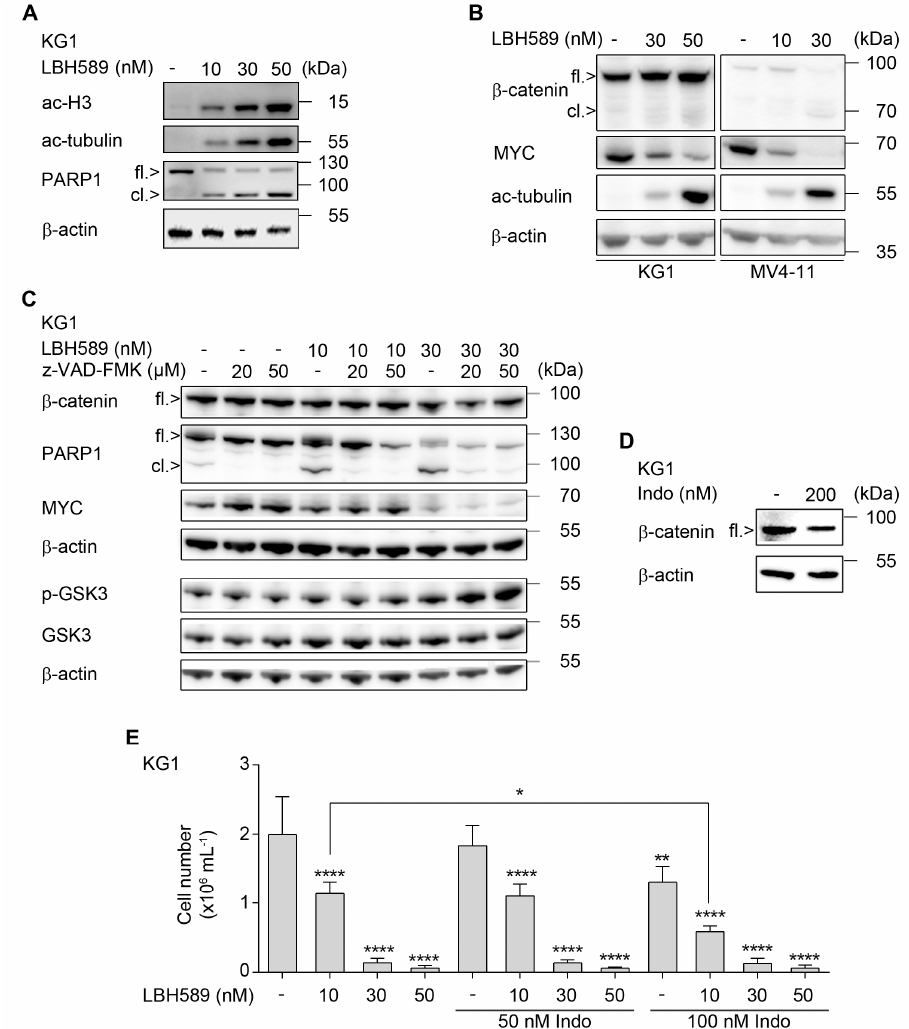
Figure 3. Effects of LBH589 and indomethacin on β -catenin and cell proliferation. ( A ) KG1 cells were incubated with 10 nM, 30 nM, or 50 nM of LBH589 for 24 h. Indicated proteins were detected via Western blot (fl., full-length; cl., cleaved); with β -actin loading as control ( n = 2). ( B ) KG1 and